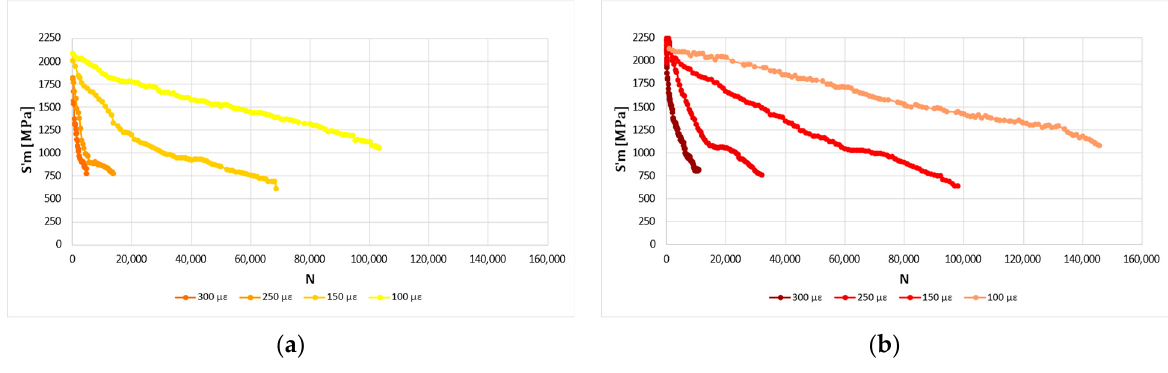
Figure 8. Stiffness curves’ varying ε 0 . ( a ) MA; ( b ) MD.